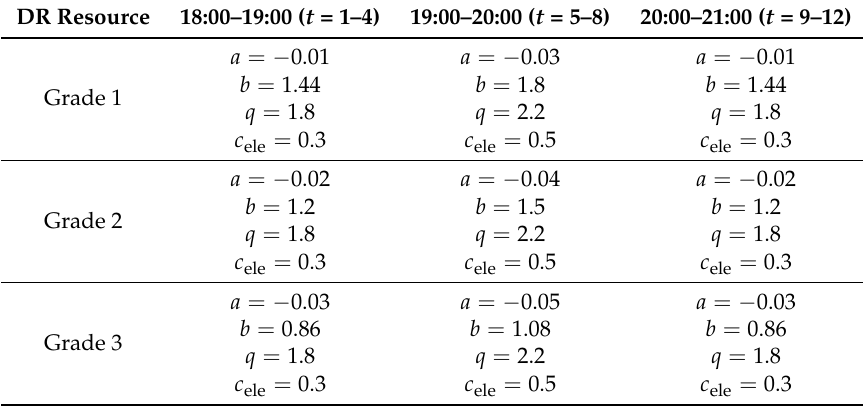
Table 1. Price parameters for different grades of DR